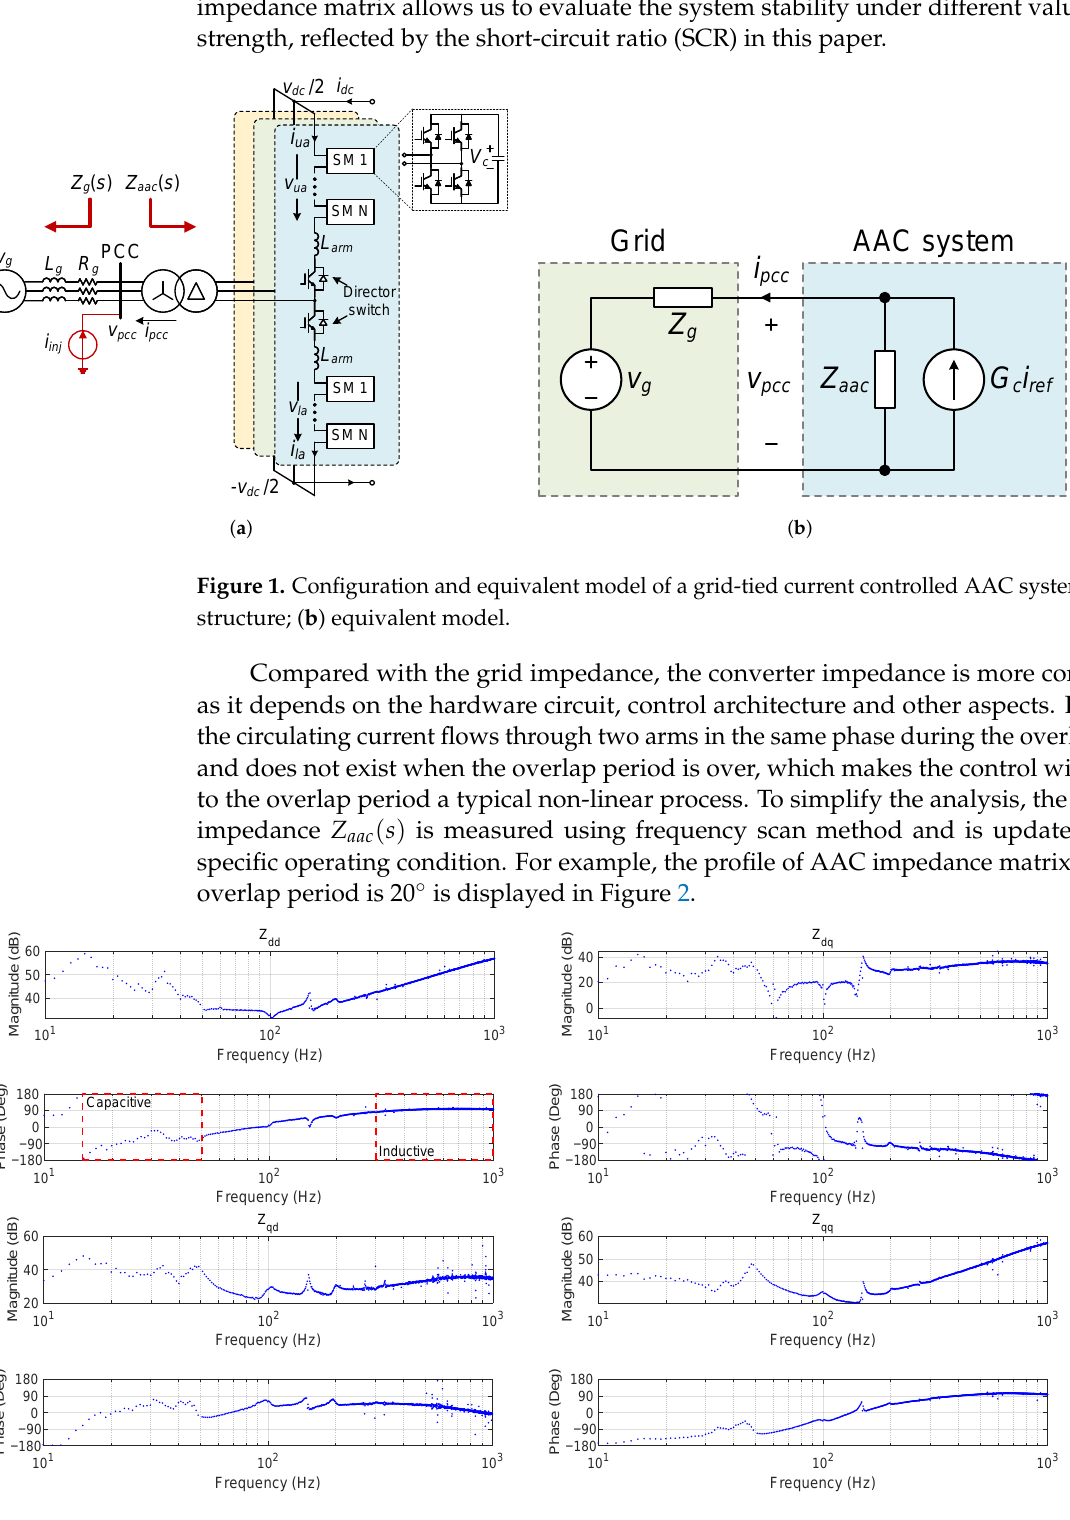
Figure 2. Frequency scan results of AAC converter impedance Z g ( s ) (overlap period is 20 ◦